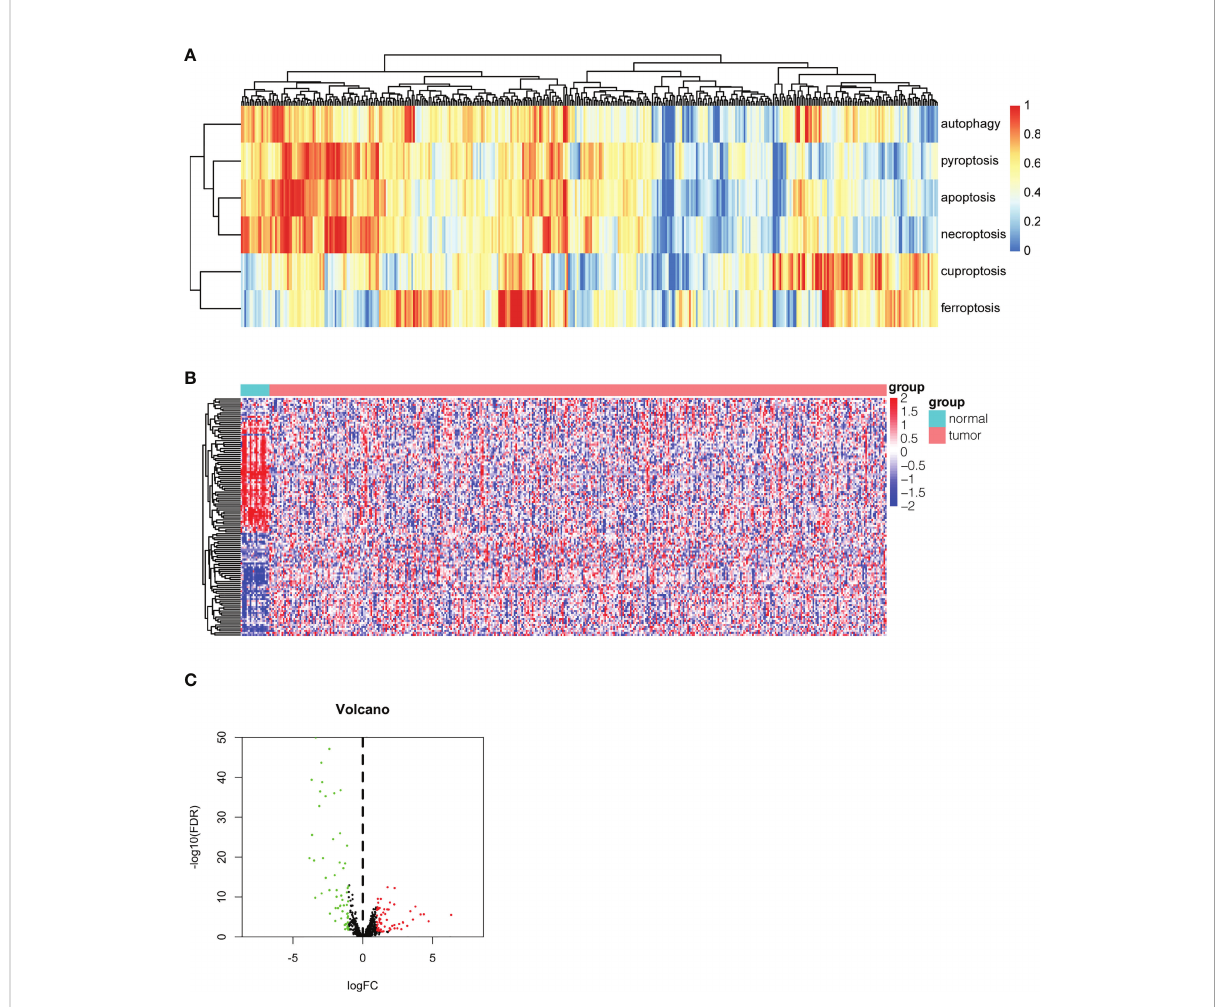
FIGURE 1 Identi fi cation of differentially expressed Pan-PCD-related genes in bladder cancer. (A) Heatmap of ssGSEA showing the enrichment scores of the Pan-PCD gene set in each bladder cancer tissue. (B) The heatmap revealed the expression level of 378 Pan-PCD-related genes between tumor and normal tissues. (C) The volcano plot displays Pan-PCD DEGs discovered in tumor tissue. Sixty-one genes showed signi fi cantly higher expression (red dots), whereas 59 genes showed signi fi cantly lower expression (green dots) in bladder